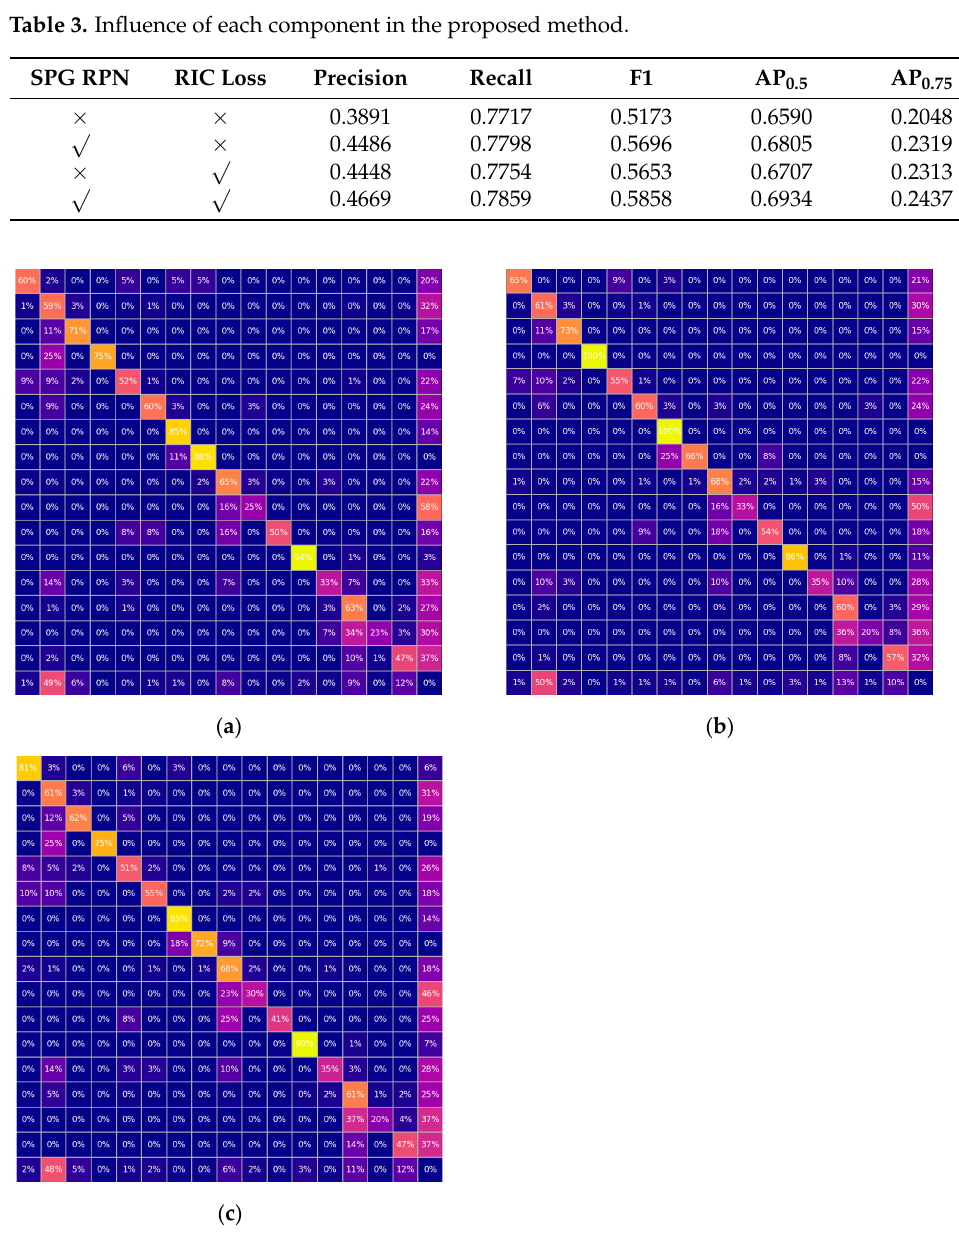
Figure 7. Visualization of the results by confusion matrixes of Oriented-RCNN and our method. The horizontal axis corresponds to the predicted label and the vertical axis corresponds to the ground-truth label, respectively. Rows or columns 1 to 17 correspond to ore-oil, Container, Fishing, LawEnforce, Dredger, Cell-Container, Type1-10, and background, respectively. ( a ) The confusion matrix of Oriented-RCNN. ( b ) The confusion matrix of SPG-OSD.